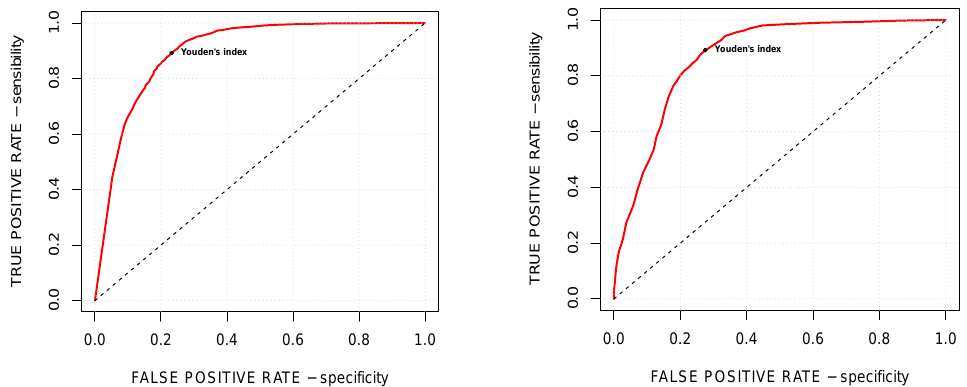
Figure 4. ROC curves for the local ( left panel ) and the global ( right panel ) methods. The markers make evident the corresponding Youden’s